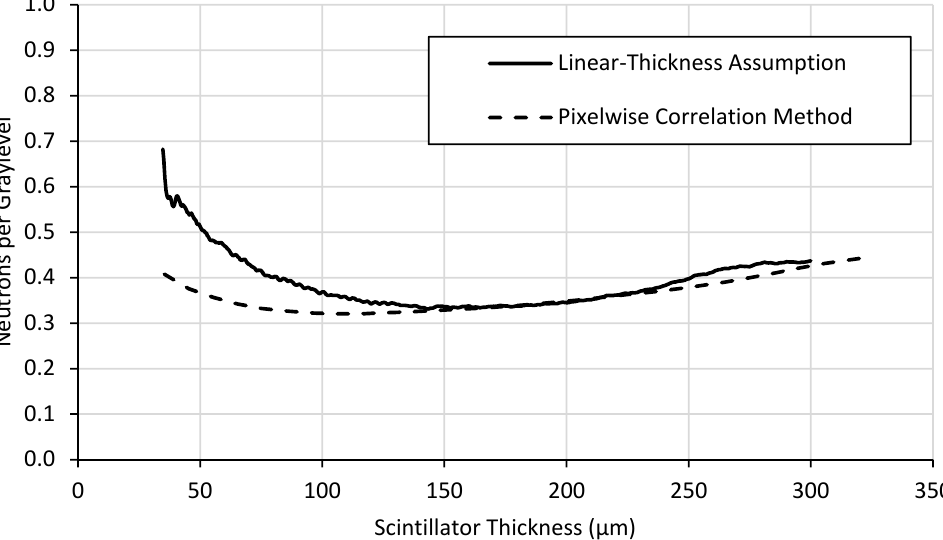
Figure 9. Correlation of neutron absorption to light yield using the two methods for a 6 LiF:ZnS test- screen.